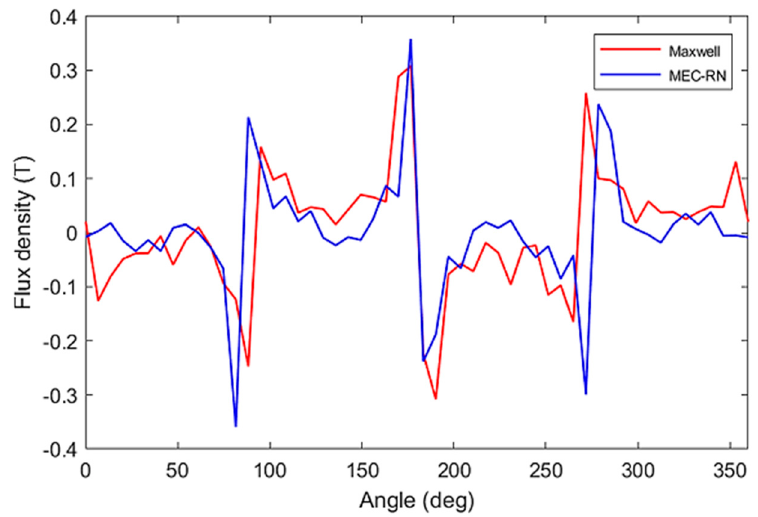
Figure 11. Axial flux density in the high-speed rotor air gap.